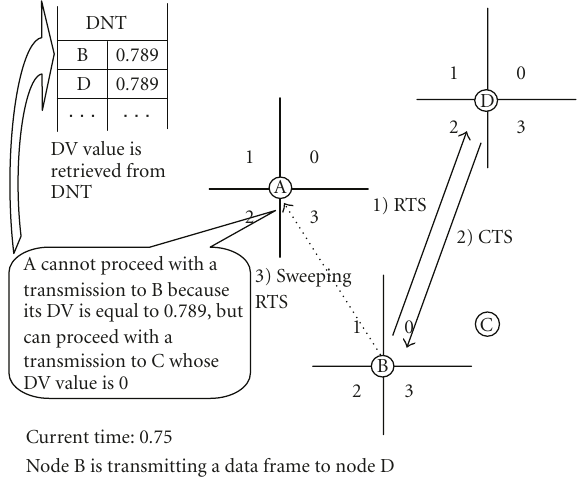
Figure 11: Illustration of the DA1 mechanism.